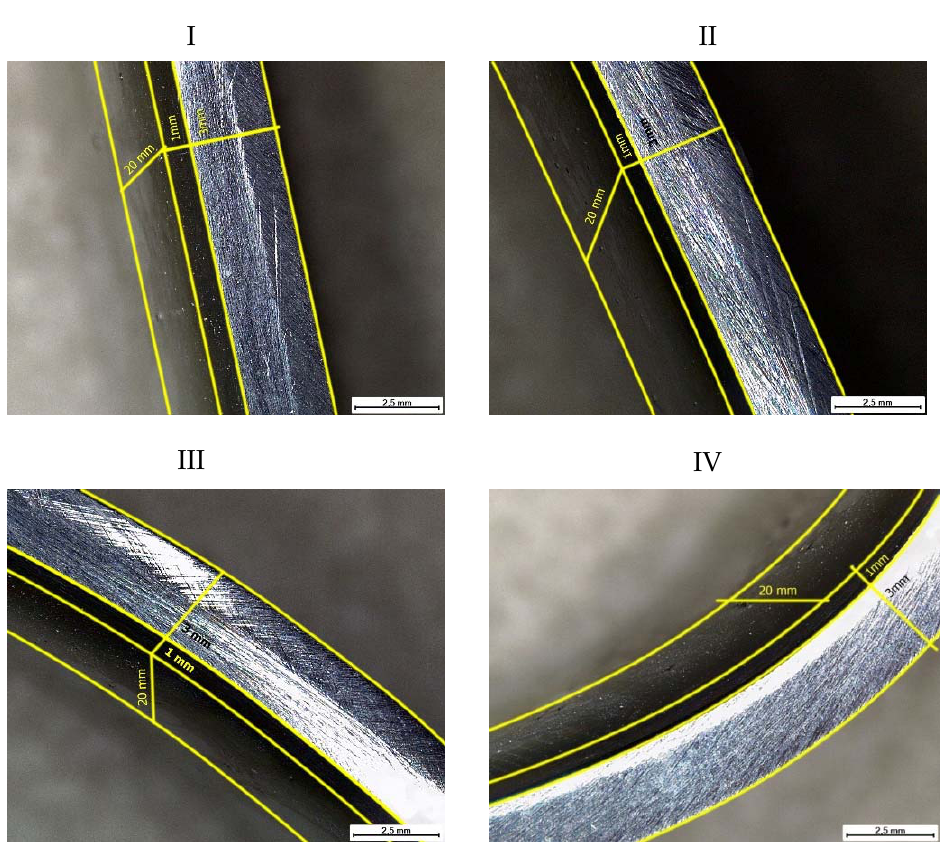
Figure 9. Microscopic images of the cross section of coated samples for various stages of plastic deformation under loading: I stage– F = 1.251 kN, Δ L = 1.541 mm; II stage– F = 1.441 kN, Δ L = 2.346 mm; III stage– F = 1.547 kN, Δ L = 3.052 mm; and IV stage– F = 1.468 kN, Δ L = 5.423 mm.